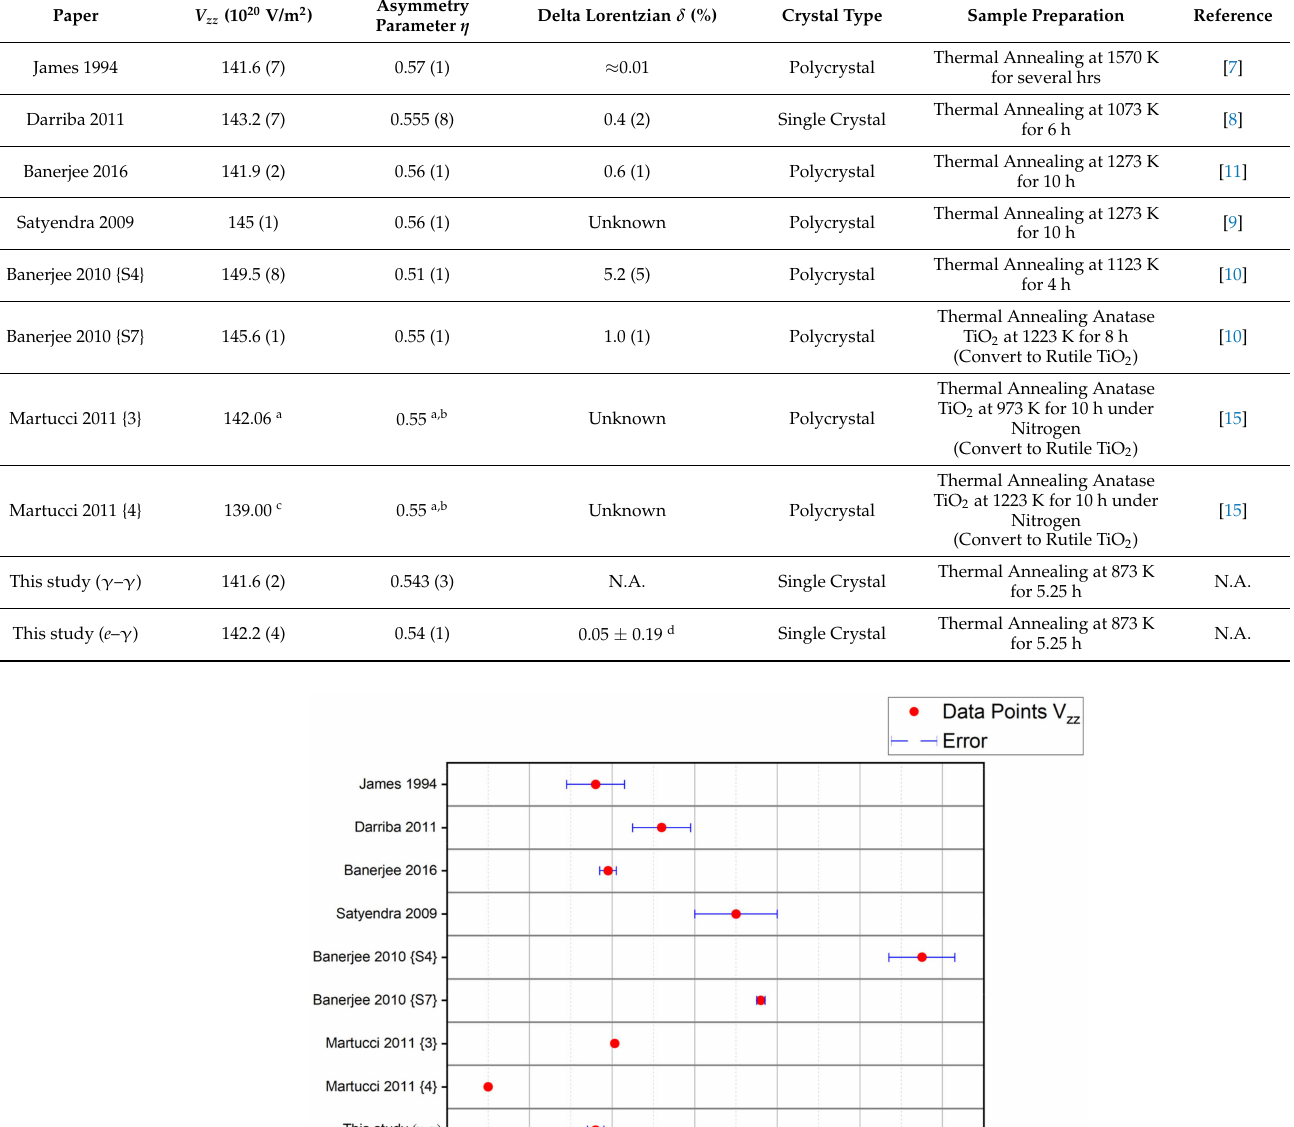
Table 4. Published literature values (after correcting for the quadrupole moment of 181 Ta according to reference [51]) of the relevant hyperfine parameters for the 181 Ta(TiO 2 ) γ − γ TDPAC spectroscopy compared with the hyperfine parameters obtained from our γ − γ and e − γ experiments. We note that across all the papers mentioned below, they did not consider the dominant systematic uncertainty of the quadrupole moment as quoted in reference [51]. Hence, for our values, we only consider the statistical uncertainty caused by our instruments. Note that (a) Martucci et al. did not include the uncertainty in their report, (b) they mentioned that their asymmetry parameters agree with the reference [10], (c) they also mentioned that discrepancy of V zz of their sample 4 concerning the literature values is due to the presence of the fluorine atoms (A byproduct caused by their preparation method) near the 181 Ta probe, and (d) the averaged δ is written in this form, as its uncertainty exceeds its value.